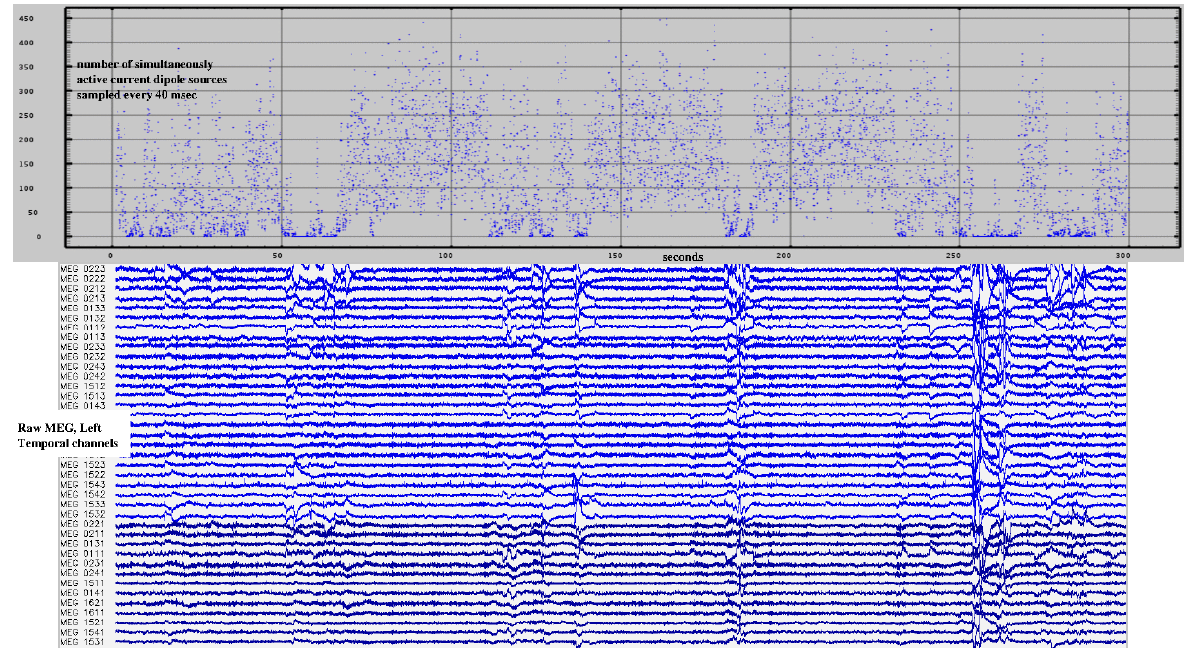
Figure 9. The referee consensus solver automatically fails when the recordings are noisy. 300 s of raw magnetoencephalo- graphic (MEG) ( lower ) and neuroelectric currents ( upper ) are shown. The number of validated ( p < 10 − 12 ) currents identified drops markedly when the MEG is noisy.